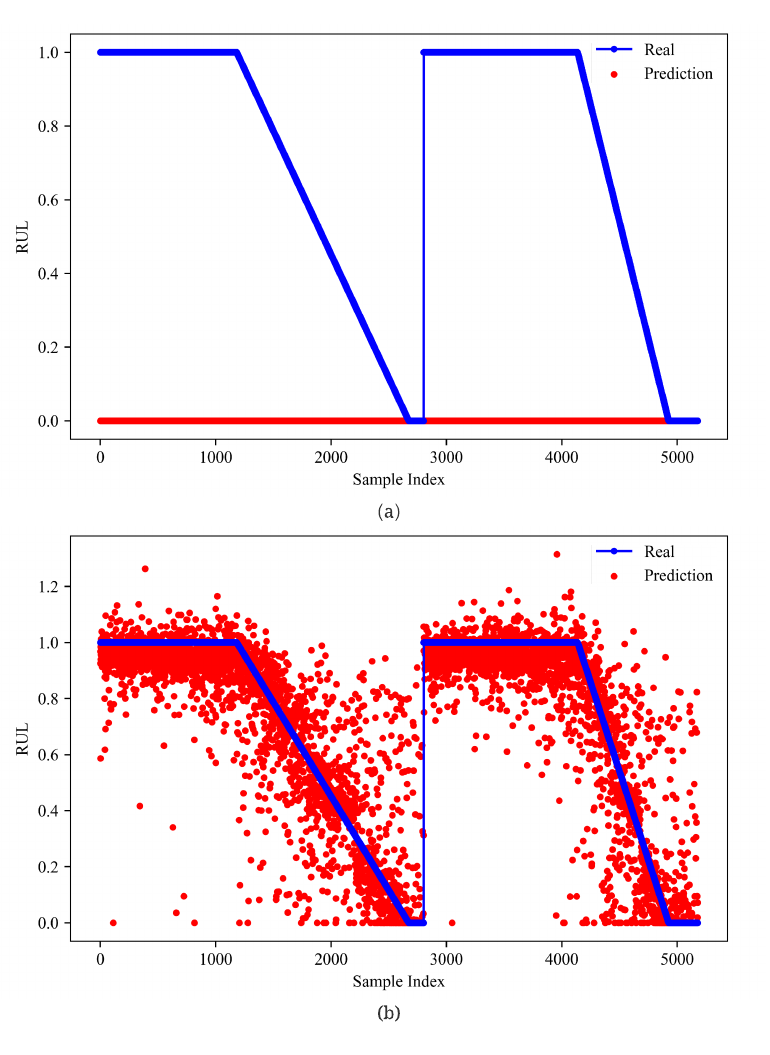
Figure 13. RUL prediction of models ( a ) LSTM. ( b ) GRU. Samples from bearing 1_1 and bearing 1_3 are joint from left to right.